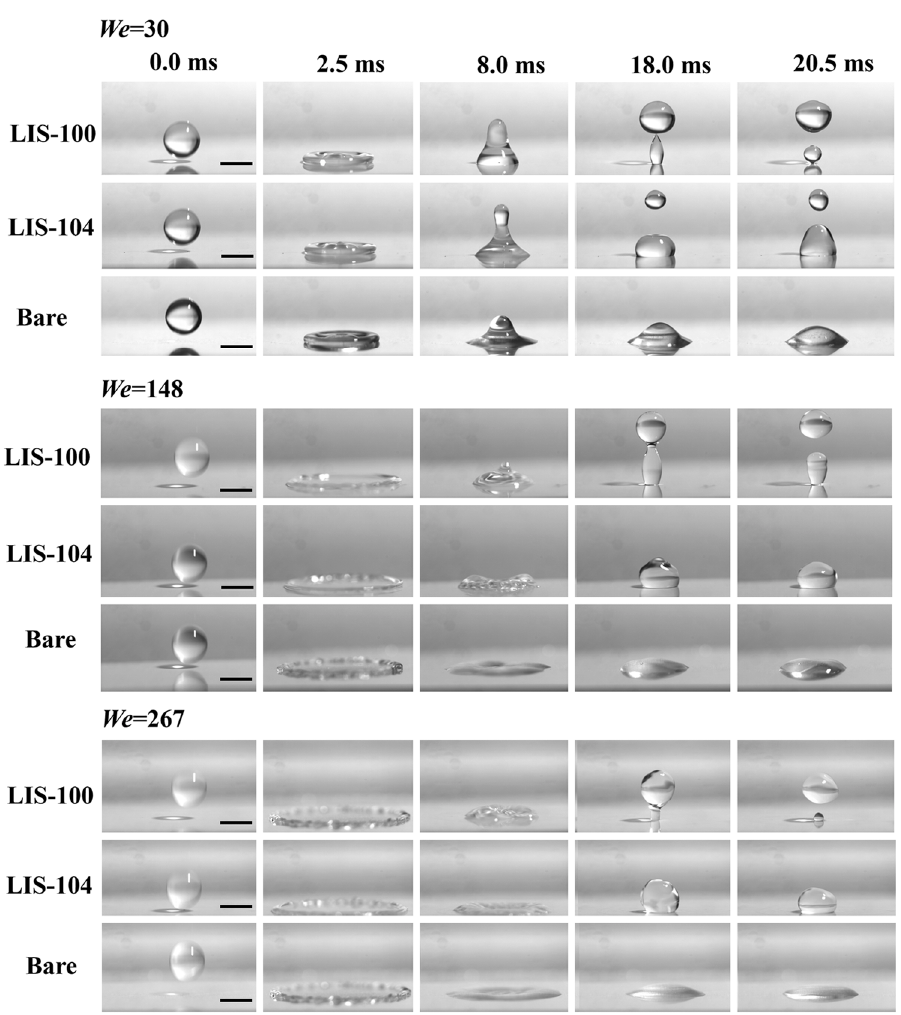
Figure 3. Time evolution of a water drop impacting sample surfaces at different We numbers. The time scale is the same for the samples and the scale bar is 2 mm.